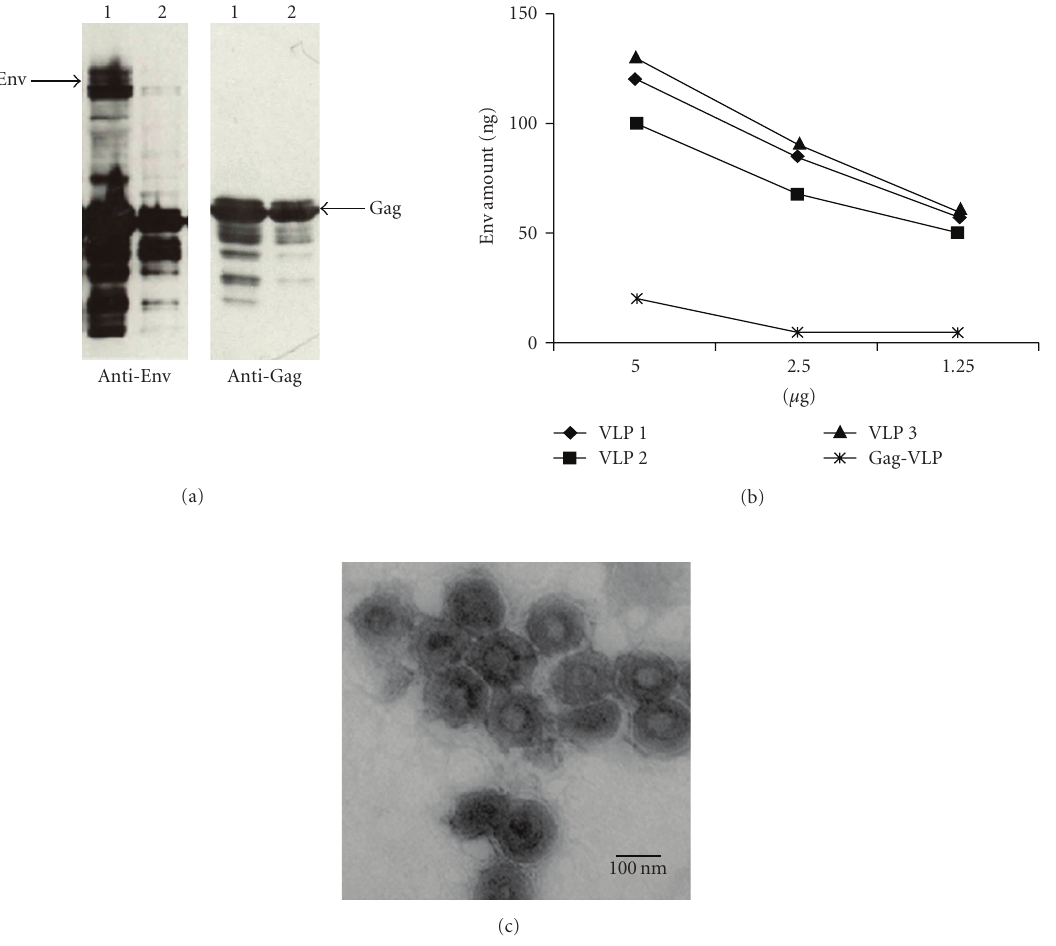
Figure 1: Characterization of SHIV 89.6 VLPs. SHIV 89.6 VLPs were produced by coinfection of Sf9 cells with rBVs expressing HIV 89.6 Env and SIVmac239 Gag proteins at the MOI (multiplicity of infection) of 5 and 2, respectively, and purified as described in Section 2. SIV Gag VLPs were produced by infection of Sf9 cells with rBV expressing SIVmac239 Gag proteins and purified similarly. (a) Characterization of SHIV 89.6 VLPs by Western blot. 5 μ g total proteins were taken from each VLP preparation and analyzed by SDS-PAGE followed by Western blot using rabbit-anti-gp120 antibody for detection of HIV Env proteins and monkey-anti-SIV fordetection of the SIV Gag proteins. Lanes 1, SHIV 89.6 VLP; 2, SIV Gag-only VLP. (b) Comparison of HIV 89.6 Env amount in VLP preparations by a quantitative ELISA. The amount of HIV Env proteins in SHIV 89.6 VLP preparations was determined by a sandwich ELISA. ELISA plates were coated with a sheep-anti- gp120 antibody as the capture antibody, followed by addition of serial 2-fold dilutions of SHIV 89.6 VLPs lysed by 1% Triton X-100. The amount of HIV Env bound to the plate was then detected by sera from HIV-infected patients as the detecting antibody, followed by addition of HRP-conjugated Goat-antihuman antibody and development of color. Lysed SIVmac239 Gag VLPs were used as controls. A standard curve for the amount of HIV Env was obtained by adding purified HIV 89.6 Gp120 mixed with SIVmac239 Gag VLP lysed by 1% Triton X-100 to the sheep-anti-gp120 antibody-coated ELISA plate. The amount of HIV Env proteins was then calculated based on the obtained standard curve and then expressed as nanograms (ng) of HIV Env in 1 μ g VLP preparation. VLP1, VLP2, and VLP3 represent SHIV 89.6 VLPs produced from three di ff erent batches and Gag-VLP represents the control SIVmac239 Gag only VLP preparation. (c) Negative staining and EM examination of SHIV 89.6 VLPs. Purified SHIV 89.6 VLPs were stained with 1% uranyl acetate followed by examination under a transmission electron